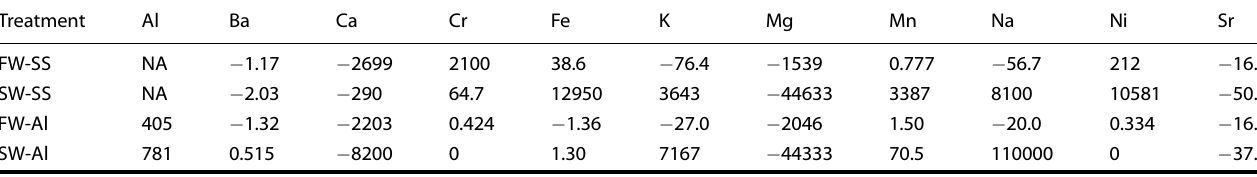
Table 3. Change in metal concentrations (µg L − 1 ) following treatment measured by ICP-OES. Treatment